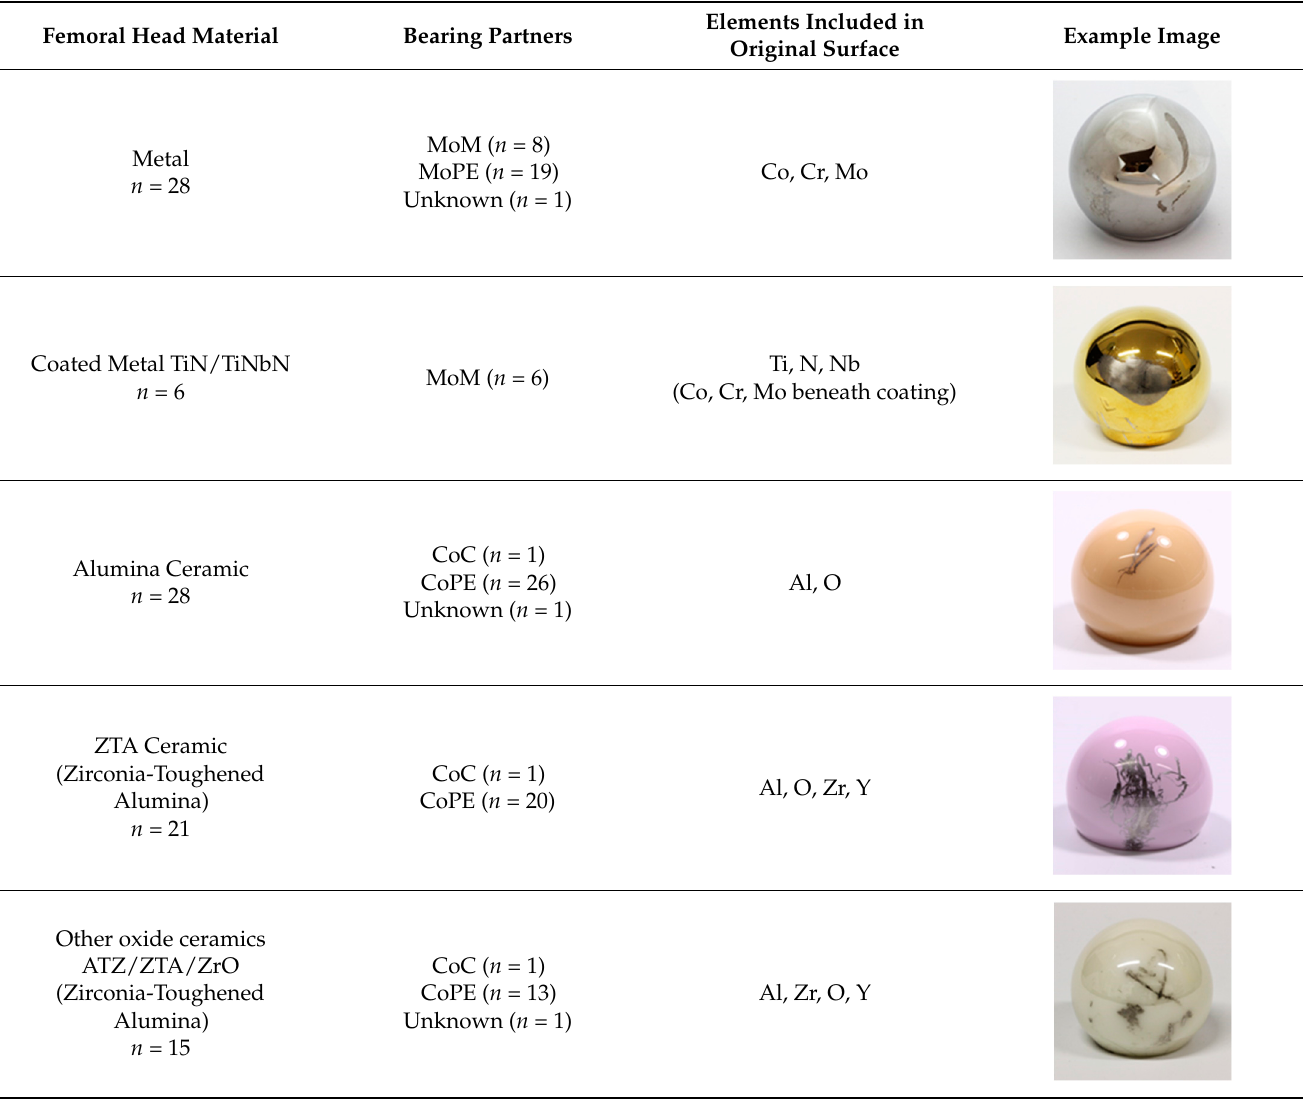
Table 1. Selection of femoral heads with metallic depositions on original surface and associated bearing partners (MoM = metal on metal, MoPE = metal on PE, CoC = ceramic on ceramic, CoPE = ceramic on PE, unknown = unknown bearing partner).